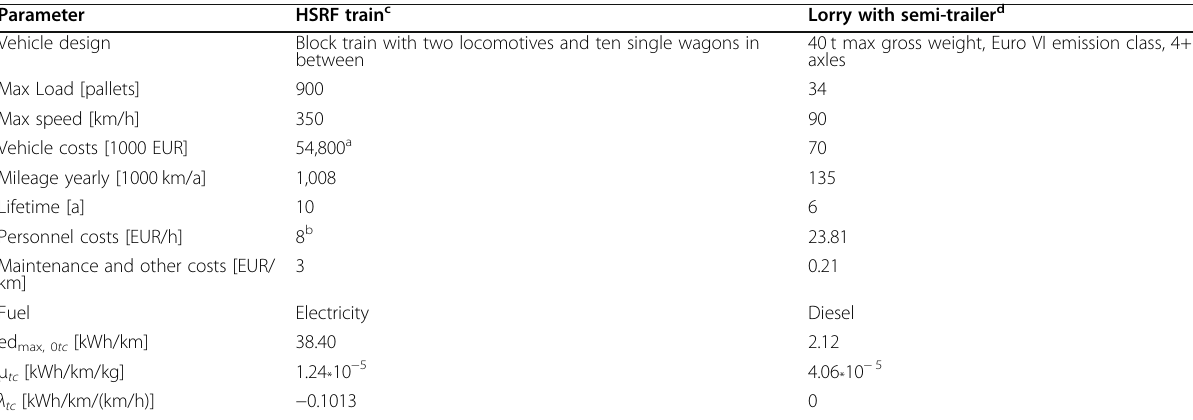
Table 2 Vehicle